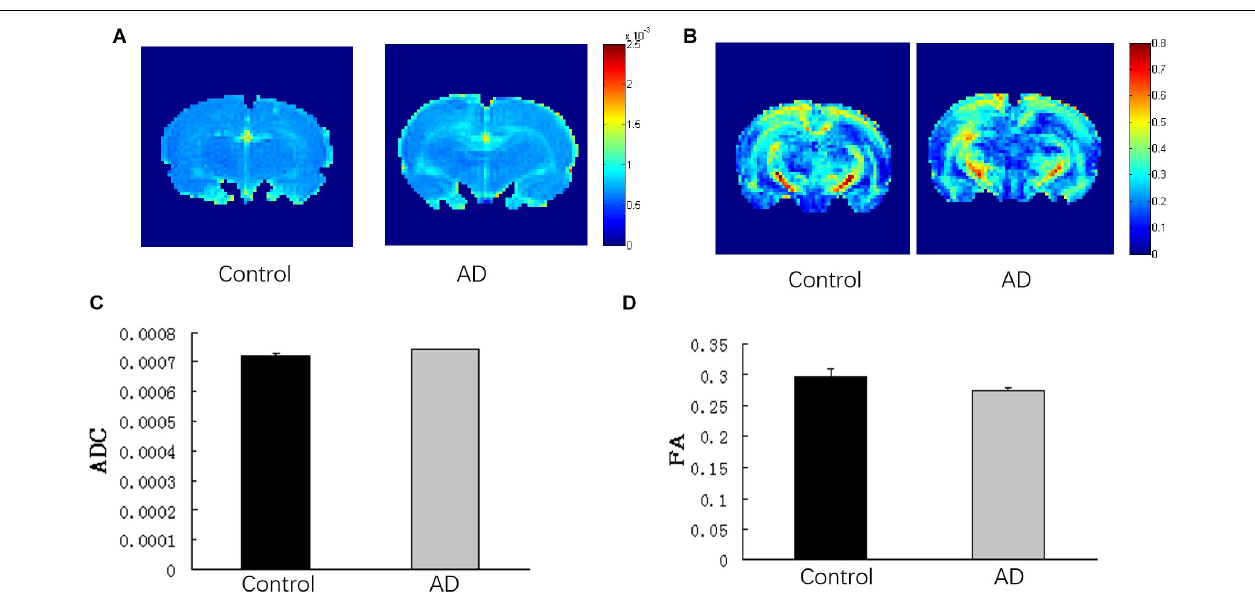
FIGURE 6 | Analysis of DTI imaging of rat brains in the AD group and control group at 28 days after A β 25–35 administration. (A) ADC images and (B) FA images of the control and AD rat brains. (C) Bar chart demonstrating the corresponding ADC value of the control and AD rats. P > 0.05. (D) Bar chart representing the corresponding FA value of the control and AD rats. P > 0.05, error bar was the standard error ( n = 6 per